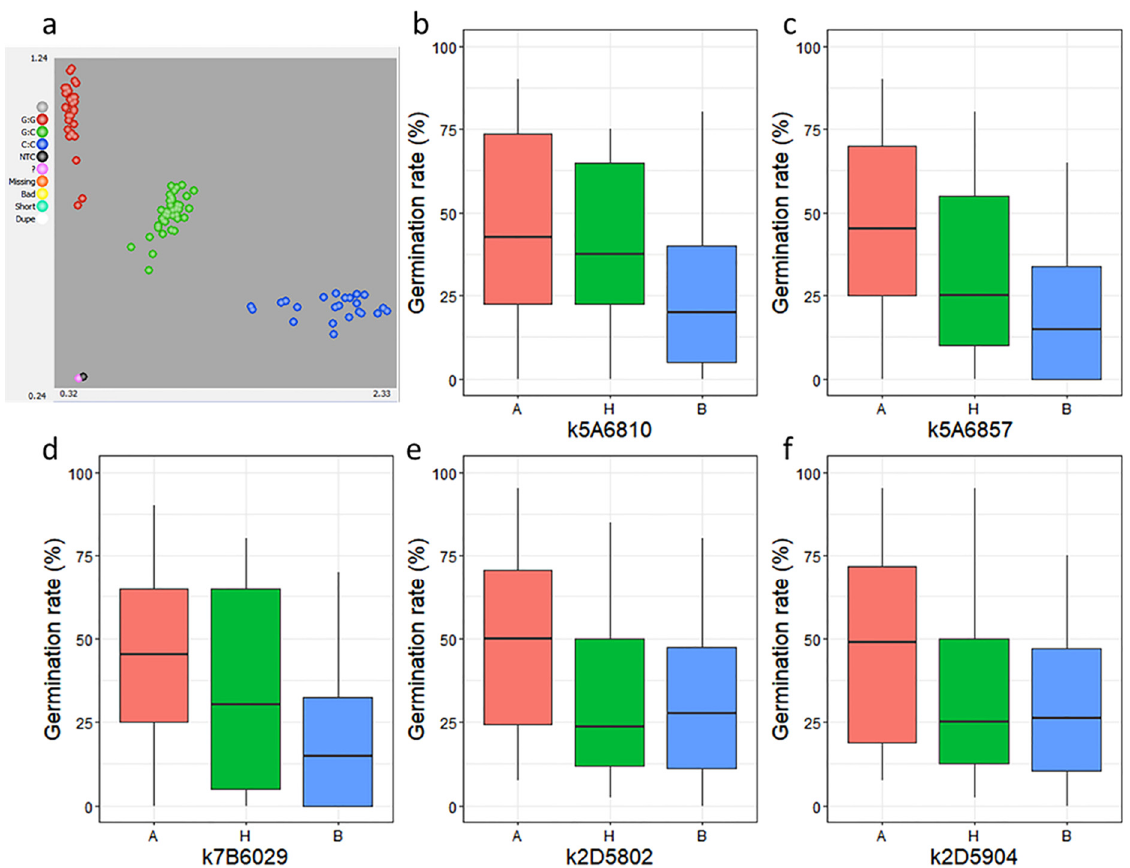
Figure 4. The phenotypic variation of five KASP markers validated in the segregation populations. ( a ) illustrates k2D5904 KASP assays screened in the Huaimai 18 × CD1840 population; ( b – d ) show the average germination rate of lines separated by the genotypes at k5A6810 , k5A6857 and k7B6029 in Shannong 135 × Siyang 936 population; ( e , f ) show the average germination rate of lines separated by the genotypes at k2D5802 and k2D5904 in the Huaimai 18 × CD1840 population. A refers to genotypes of tolerant parent Shannong 135 or Huaimai 18, B refers to genotypes of Siyang 936 or CD1840, and H is